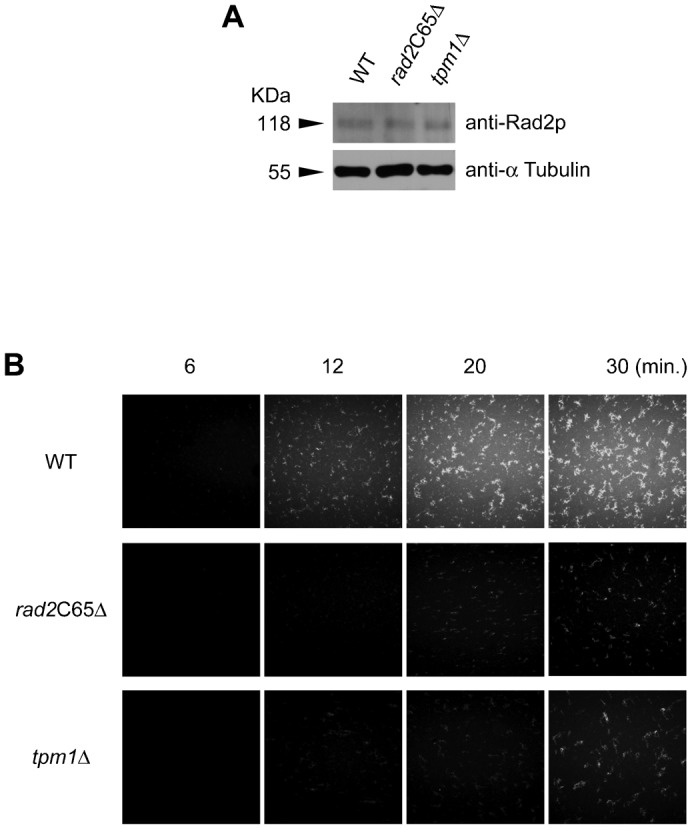
In vitro actin assembly assay.(A) Verification of Rad2p expression after UV irradiation. (B) The rad2C65Δ and tpm1Δ mutants exhibited considerably decreased actin assembly when compared to WT.